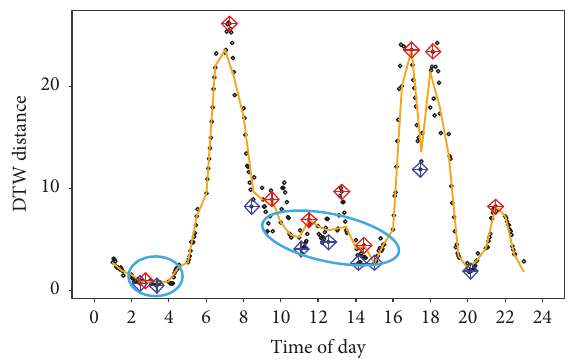
Figure 5: The DTW distance on August 11, Tuesday,